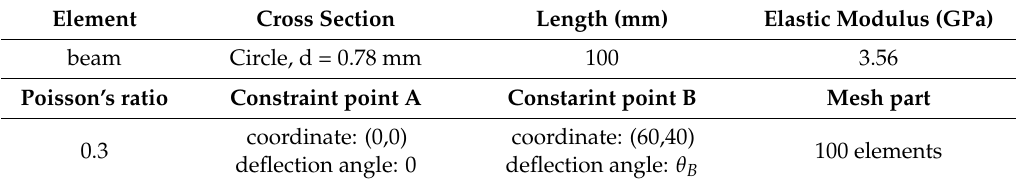
Table 3. Input data for the ABAQUS simulation of the two-point contact guidewire problem.